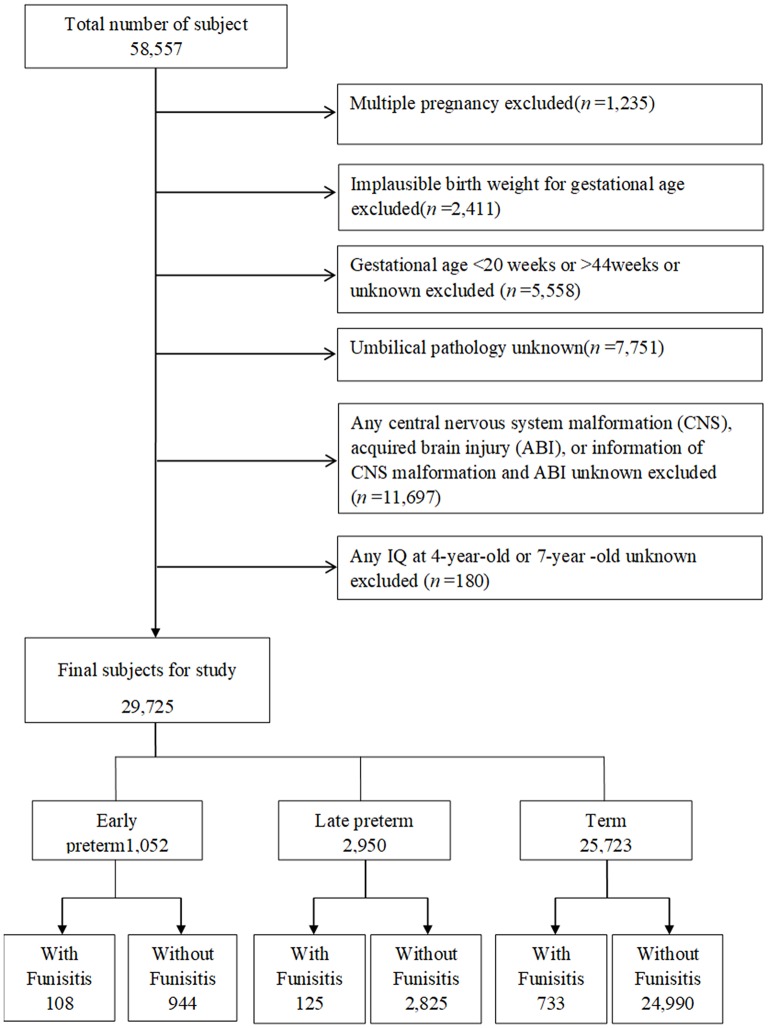
Study flow chart in the selection of study population from the U.S. Collaborative Perinatal Project. Consort diagram of study participants. CNS, central nervous system; ABI, acquired brain injury.